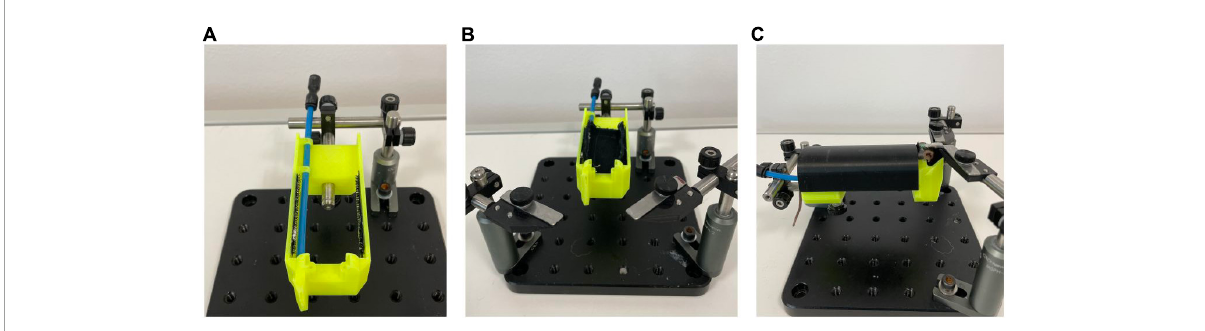
FIGURE2 Imaging stage setup for optical imaging. (A) Stage and metal rod for raising the bed. An air-puff tube delivers air-puffs through an angled stimulator at the front of the bed; (B) Fabric attached to the bed using hook and loop fastener to increase mouse comfort; (C) Mouse fixed in the imaging bed using clamps on the frontal head holder. A lid ensures minimal movement without restricting